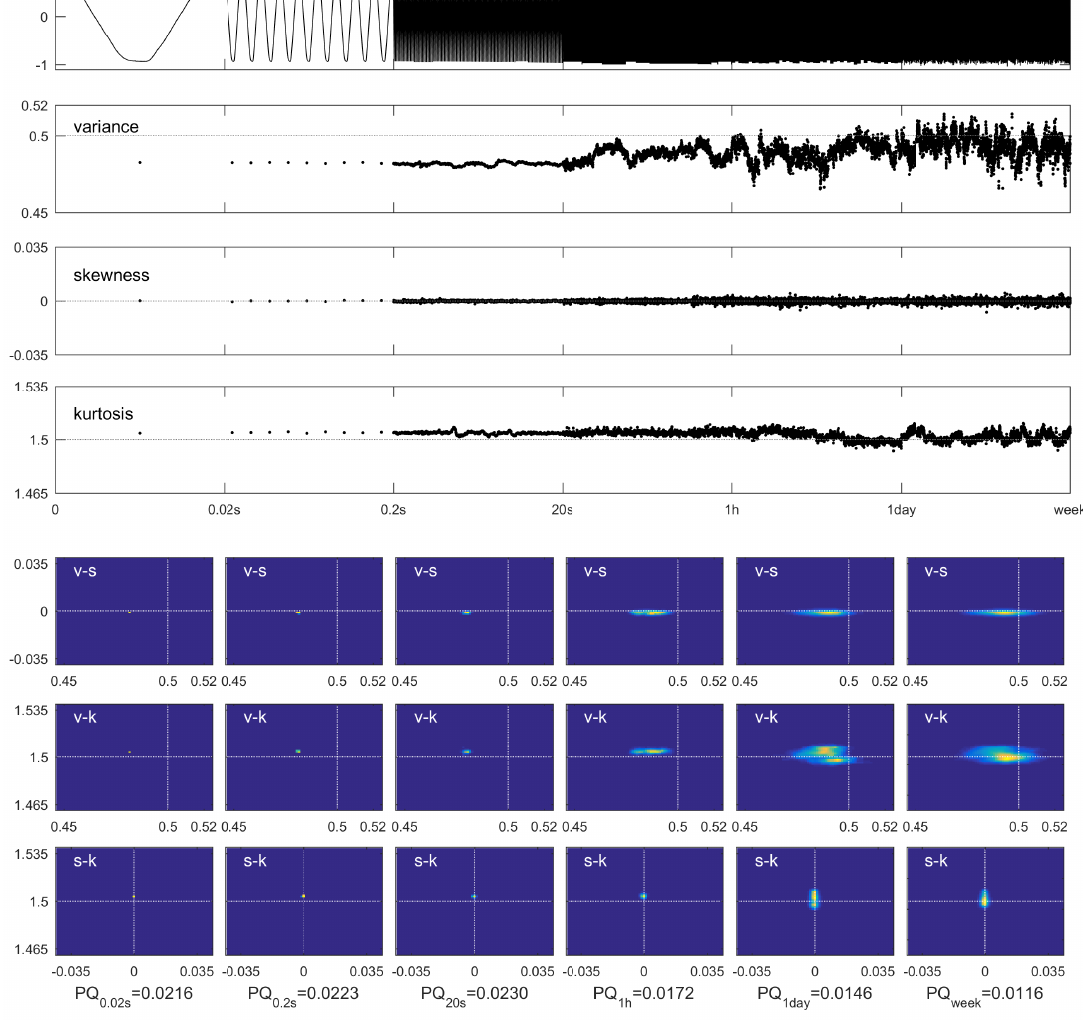
Figure 2. Monitoring of one week using the method based on HOS with a minimum resolution of one cycle. From top to bottom: complete power supply time-series; variance evolution, skewness evolution; kurtosis evolution; variance-to-skewness graph family; variance vs. kurtosis 2D graphs; skewness vs. kurtosis set of graphs. Each time interval is characterized by its associated PQ index.